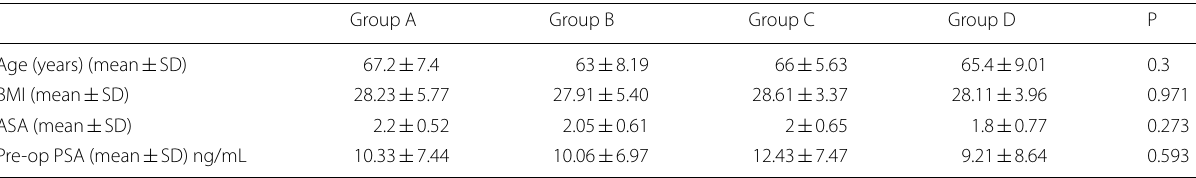
Table 1 Patient characteristics and the preoperative data